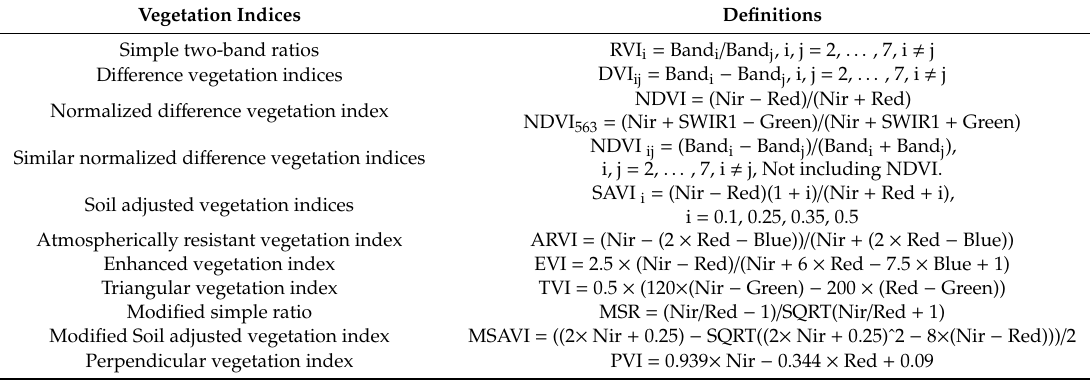
Table 3. Vegetation indices used in this